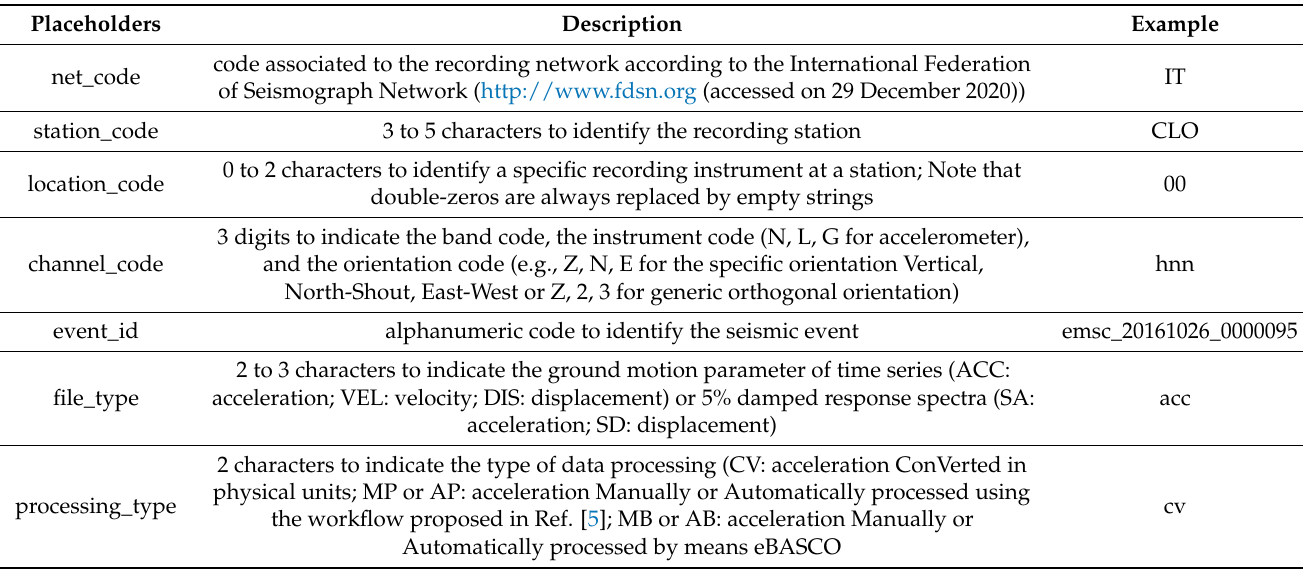
Table A2. Example of ASDF waveform tag.